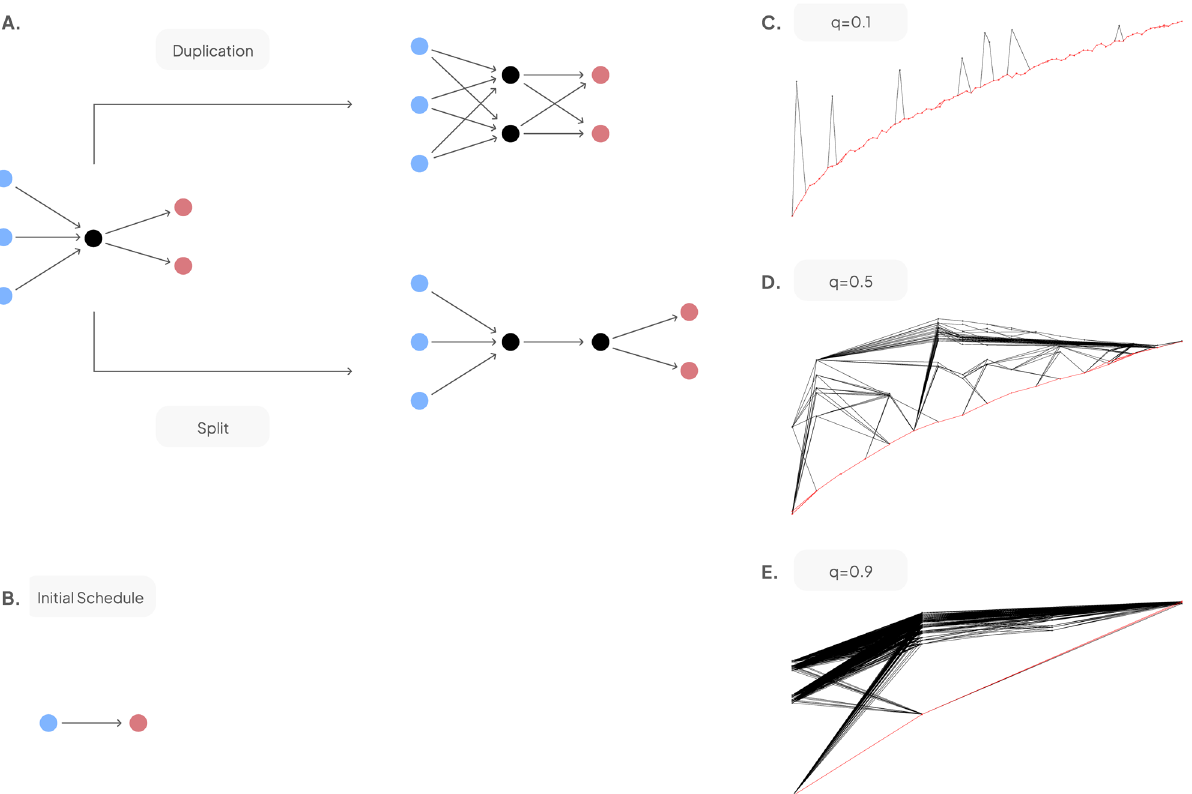
Figure 1. Duplication-split model. ( A ) Duplication and split rules acting on an activity (black). ( B ) Initial conditions where the duplication-split model is applied. ( C ) Examples of activity networks generated by the duplication-split model for three different values of the duplication probability q . Critical path is highlighted in